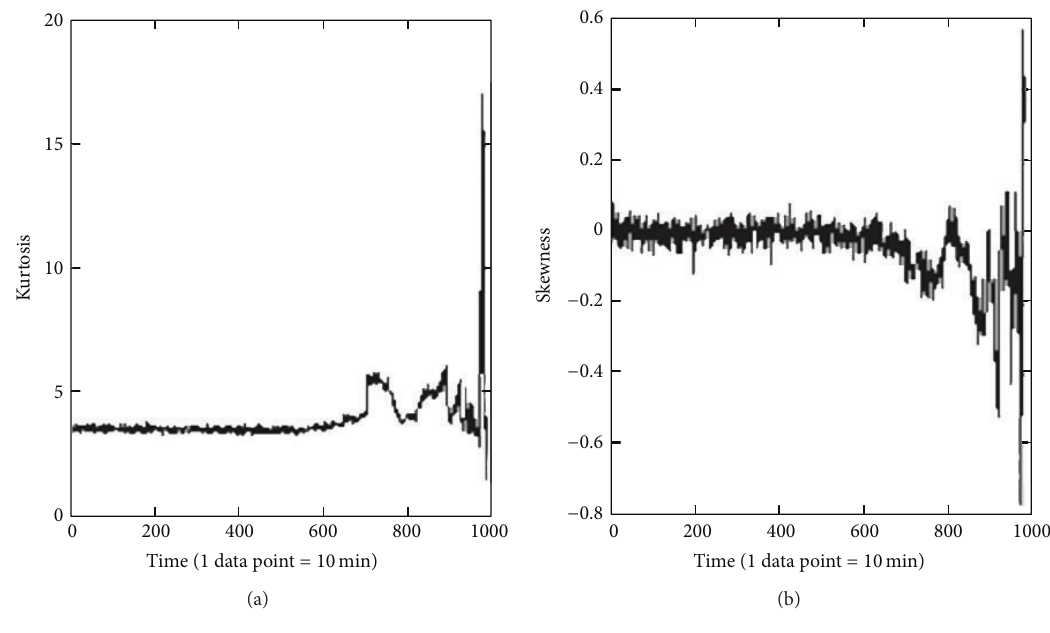
Figure 5: (a) Kurtosis value and (b) Skewness value of bearing vibration data.